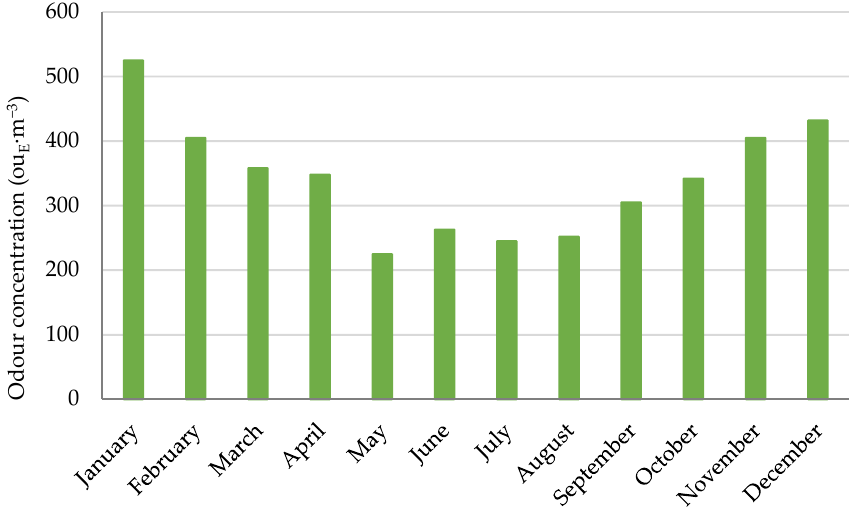
Figure 11. Mean odour concentration for dairy cows. The measured odour concentrations were in the range of the published results. The lowest odour concentration was obtained by Zhao et al. [28]. Conducting research in a free-stall dairy cattle barn with a solid floor, they observed concentrations from 79 to 142 ou E ·m − 3 during the warm and hot season. Concentrations in a similar range (9–163 ou E ·m − 3 ) on deep-litter. Akdeniz et al. [13] obtained comparable values of odour concentration ranging from 170 to 300 ou E · m − 3 . The measurements were made in two free-stall barns for dairy cows. Higher odour concentrations were observed by Maasikmets et al. [29]. During measurements in two types of barns—a tied barn with a solid manure system and a free-stall barn with a liquid manure system—the mean odour concentrations were 642 and 1483 ou E · m − 3 , respectively. Keck et al. [30] measured the odour concentration in a free-stall barn for dairy cows with a solid floor and littered cubicles, and recorded a mean odour concentration of 870 ou E · m − 3 . This is the average result of multi-point measurements carried out just above the floor surface and at a height of 3 m from the three, communication, feed area, and cubicle areas.